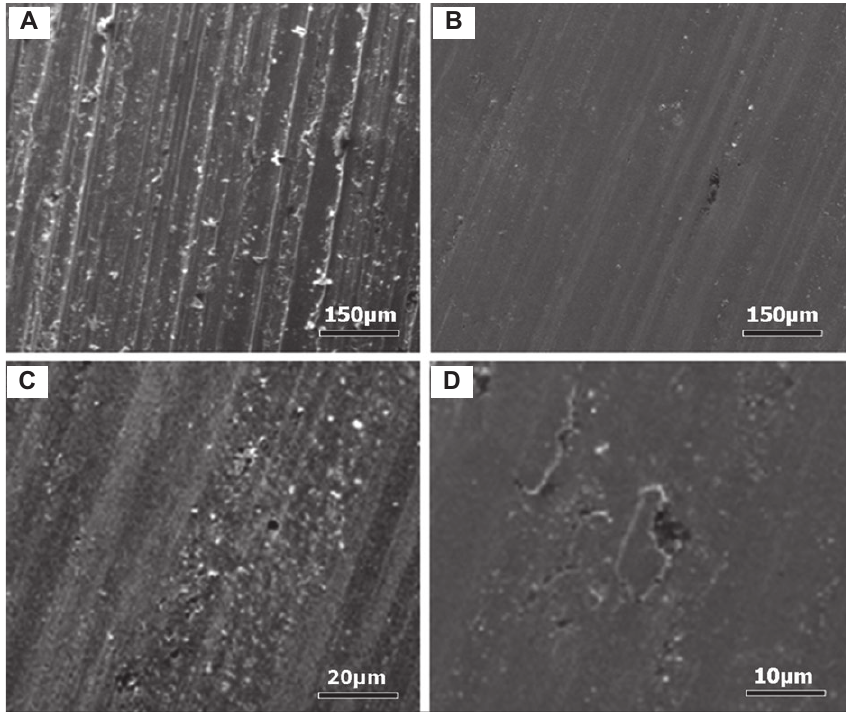
Figure 5 Wear morphologies of (A) titanium, (B) composite coating, (C) fine particles, and (D) hard ceramic asperities.